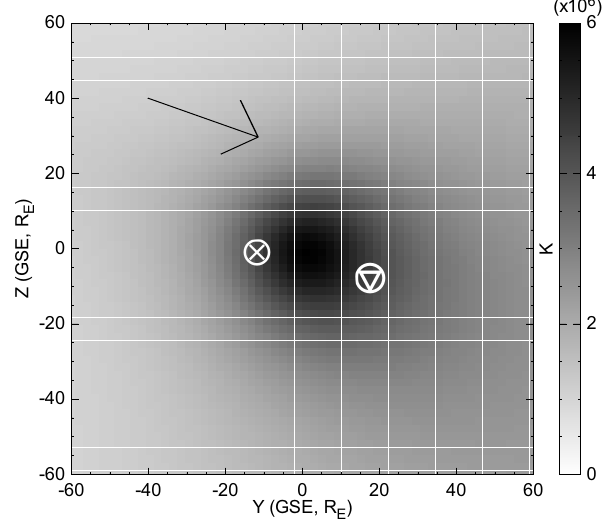
Fig. 5. A map of the Rankine-Hugoniot predicted total temperature on the bowshock surface. The upstream parameters ( B , V , ρ , and T ) are obtained from the ACE spacecraft. The circled triangle and cross show the position of THEMIS b and Cluster 2, while the arrow denotes the upstream magnetic field direction in the y-z